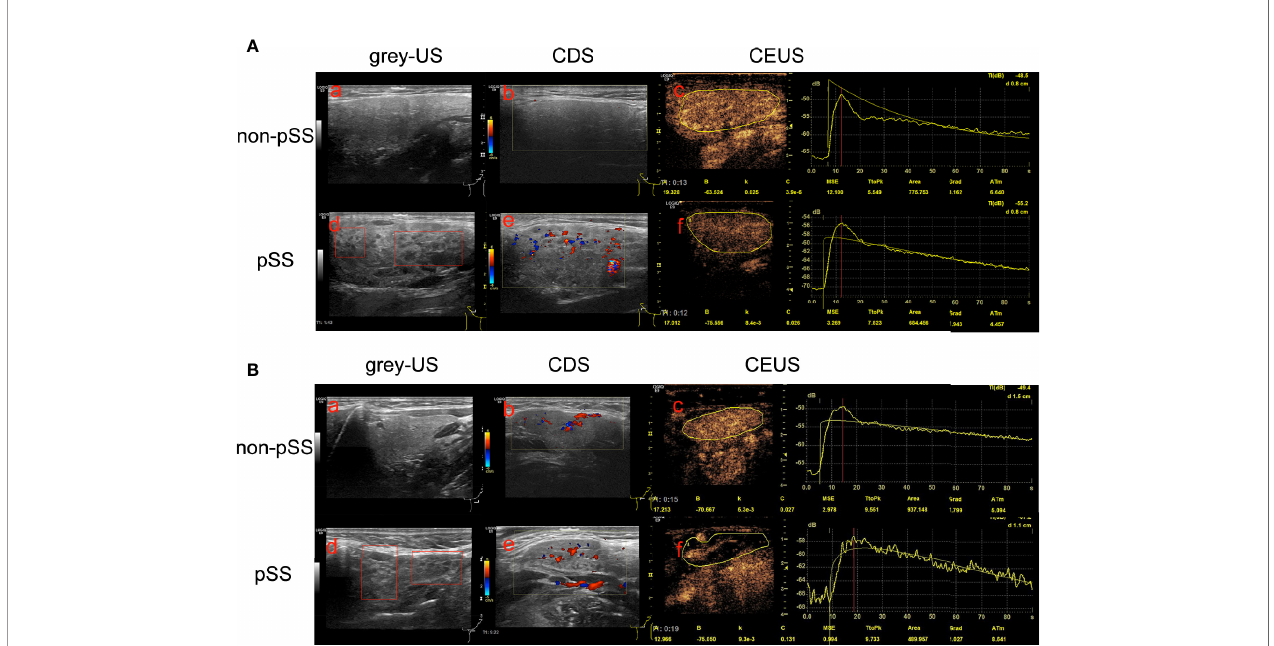
FIGURE 2 | Multimodal ultrasonographic imaging characteristics of the parotid and submandibular glands between the primary Sjögren ’ s syndrome (pSS) and non- pSS subgroups. (A) Parotid glands: (a) homogeneous parenchyma without anechoic or hypoechoic areas in the non-pSS cohort; (d) diffuse inhomogeneity with anechoic or hypoechoic areas in pSS patients; CDS identi fi ed abundant hypervascularization in pSS cohorts (e) with poor vascularization in non-pSS groups (b) ; (c, f) No echo-free areas and delay TtoP in the parotid glands of pSS compared with non-pSS cohorts. (B) Submandibular glands: (a) homogeneous parenchyma without anechoic or hypoechoic areas in the non-pSS cohort; (d) diffuse inhomogeneity with anechoic or hypoechoic areas in pSS patients; (b, e) abundant hypervascularization detected in both pSS and non-pSS patients; (c, f) massive echo-free areas without contrast enhancement and signi fi cant delay TtoP after contrast media injection in pSS patients compared with non-pSS cohorts. US, Ultrasonography; CDS, Color Doppler sonography; CEUS, Contrast-enhanced ultrasonography; pSS, primary Sjögren ’ s